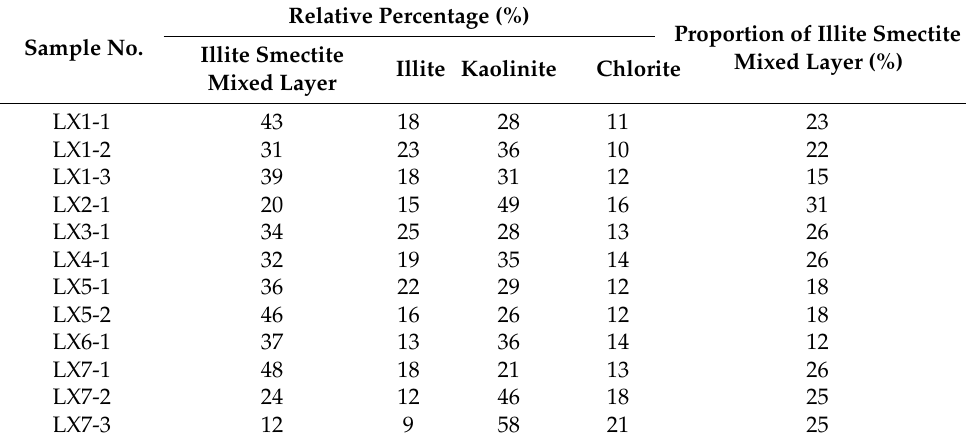
Table 3. Clay mineral compositions of the Taiyuan Formation shale, Lin-Xing area.